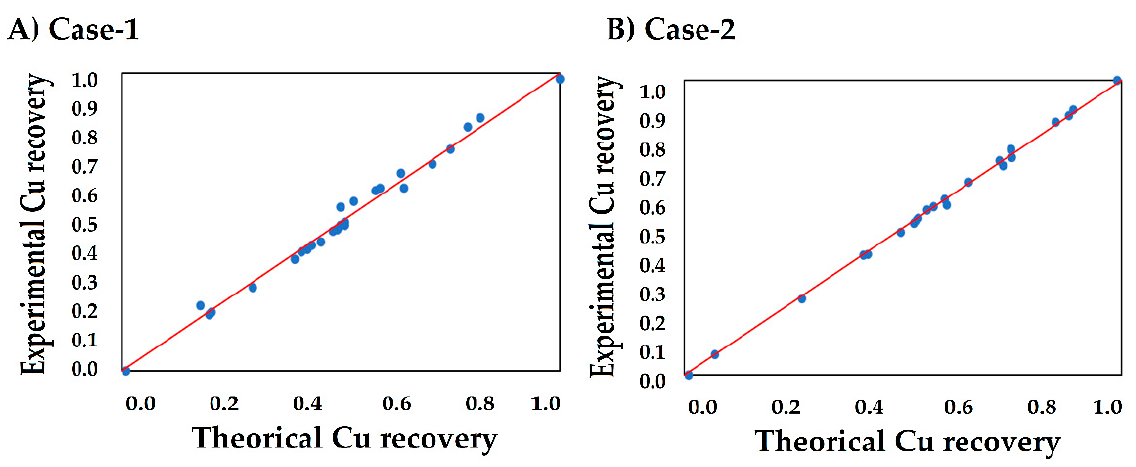
Figure 2. Neural models’ testing performance for copper recovery.